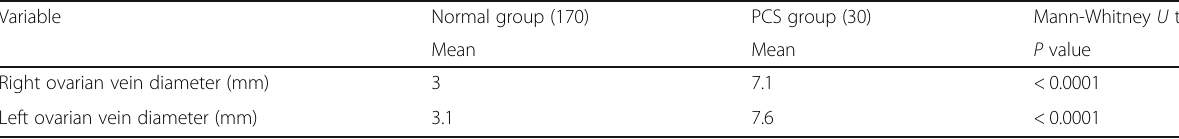
Table 1 Comparison between the 2 groups as regards ovarian vein data using Mann-Whitney ’ s U test Variable Normal group (170) PCS group (30) Mann-Whitney U test Mean Mean P value Right ovarian vein diameter (mm) Left ovarian vein diameter